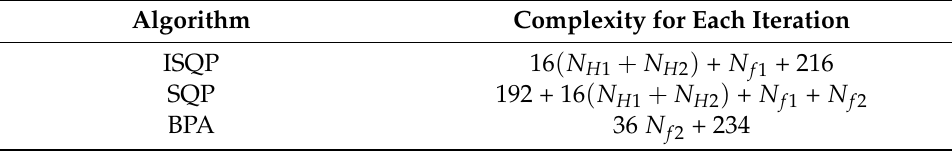
Table 5. Complexity Analysis for MIMO under Imperfect Channel Estimation.